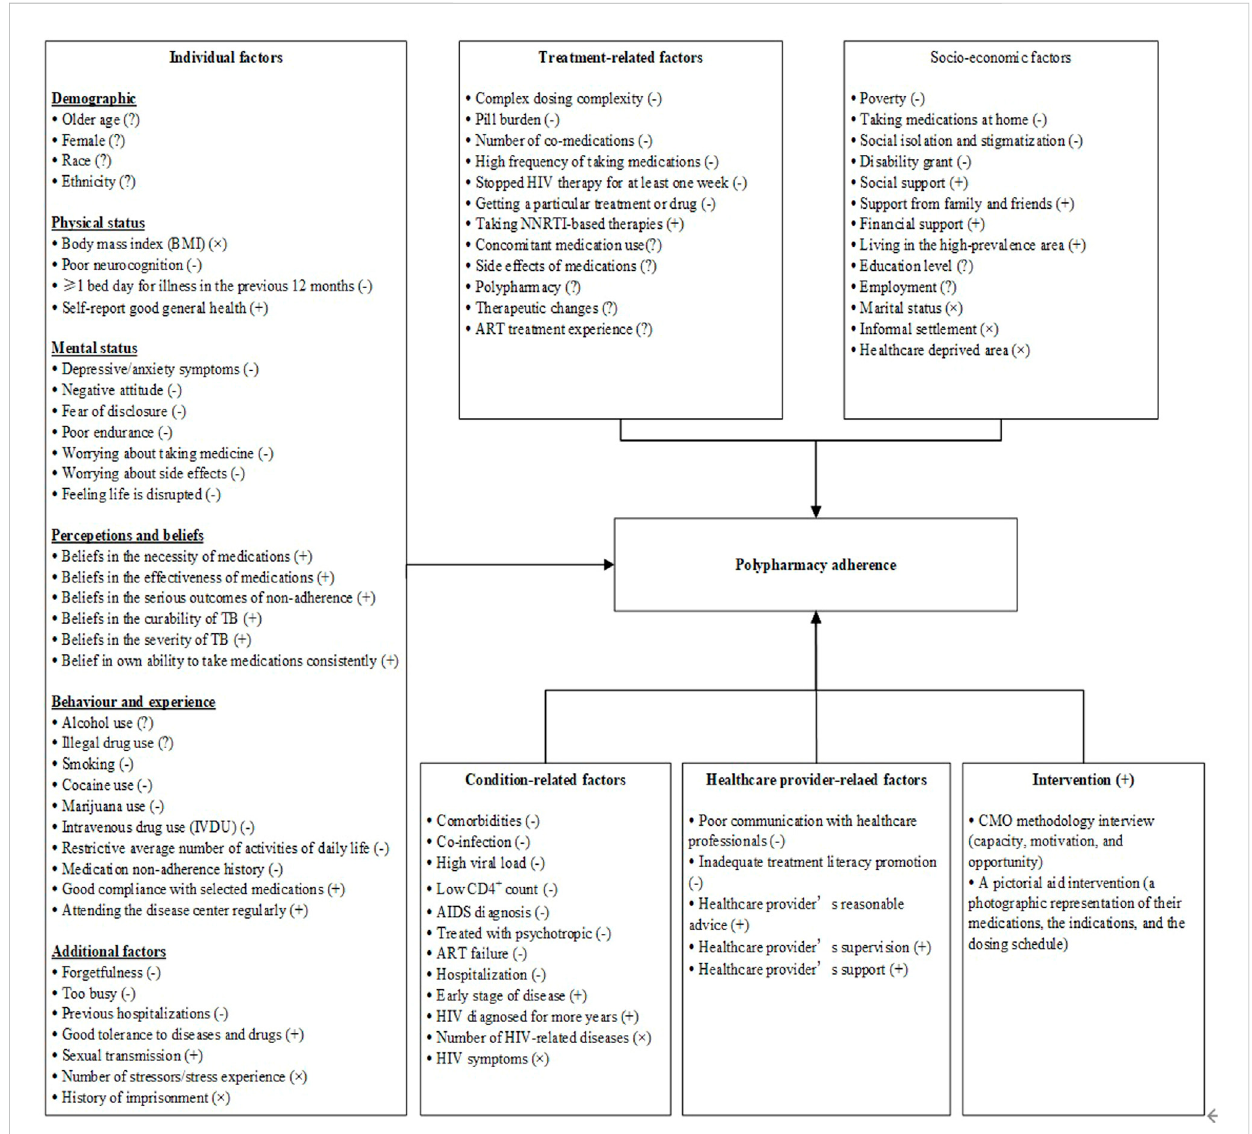
FIGURE 2 A multidimensional model for barriers and facilitators to maintaining a high level of polypharmacy adherence.